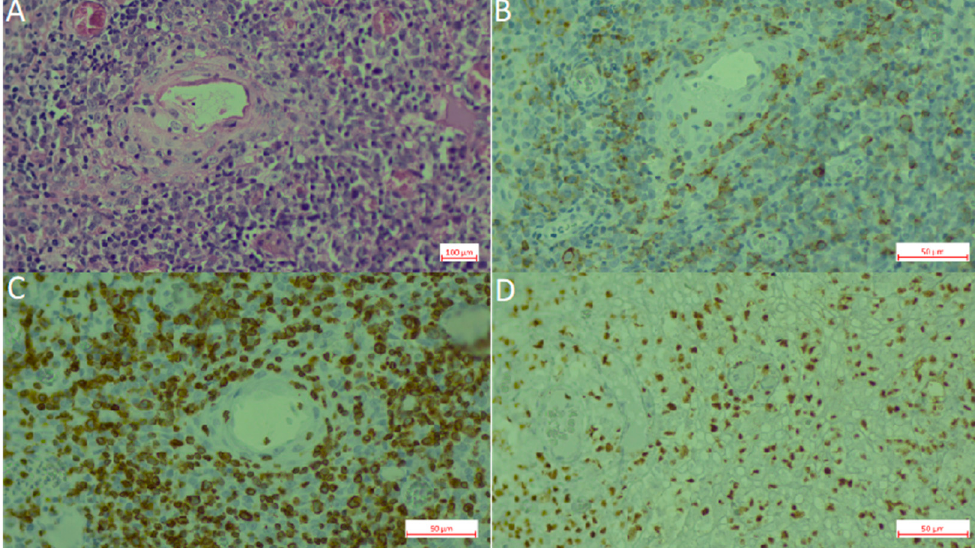
Figure 2. Extranodal natural killer (NK)/T-cell lymphoma, nasal type (ENKL). ( A ). Hematoxylin-Eosin staining. ( B ). CD56 staining. ( C ). CD3 staining. ( D ). EBER in situ hybridization.